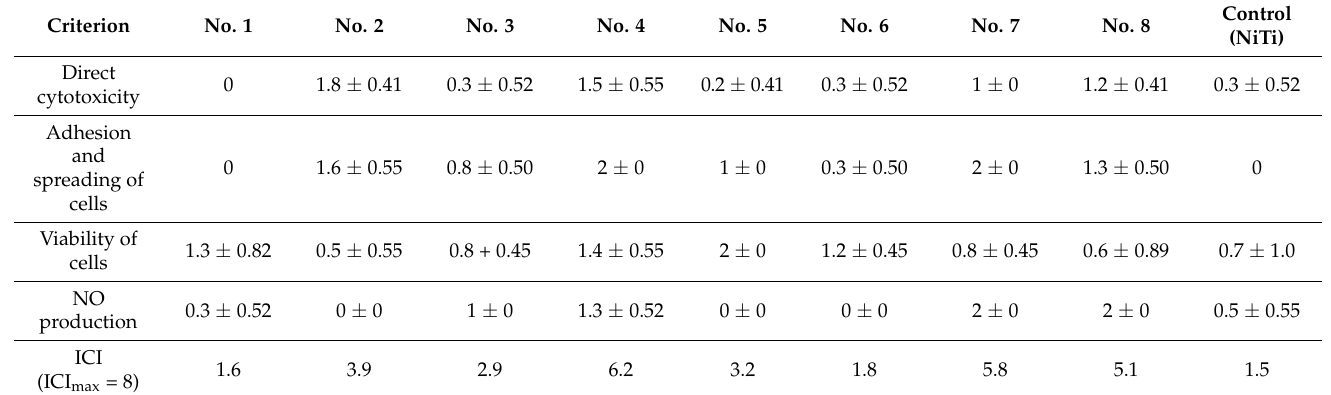
Table 4. The cytocompatibility scores of the TiO 2 and N-TiO 2 thin films.